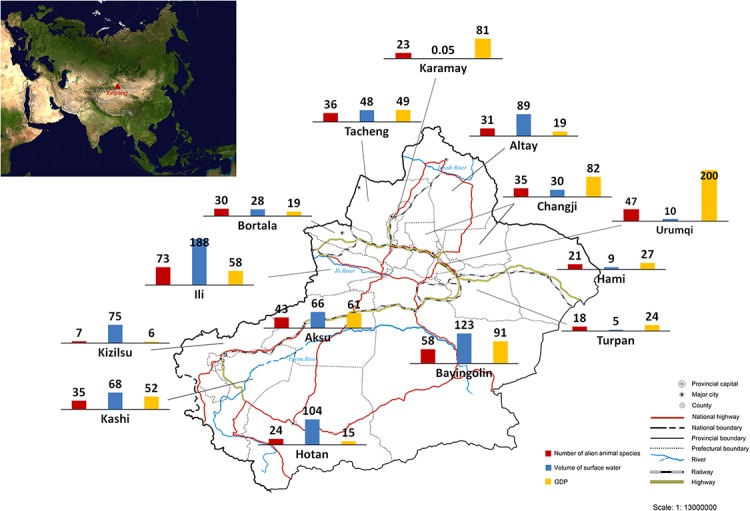
Number of recorded alien animal species, volume of surface water (107 tons) and GDP (109 Yuan RMB, equal to 1.61 × 108 USD) of each prefecture of Xinjiang.The sketch map of Xinjiang is drafted by the Xinjiang Bureau of Surveying and Mapping, and was downloaded from the public service website of the Xinjiang Bureau of Surveying, Mapping and Geoinformation at: http://www.xjch.gov.cn/article/bzdt/index.shtml (accessed on December, 2014).